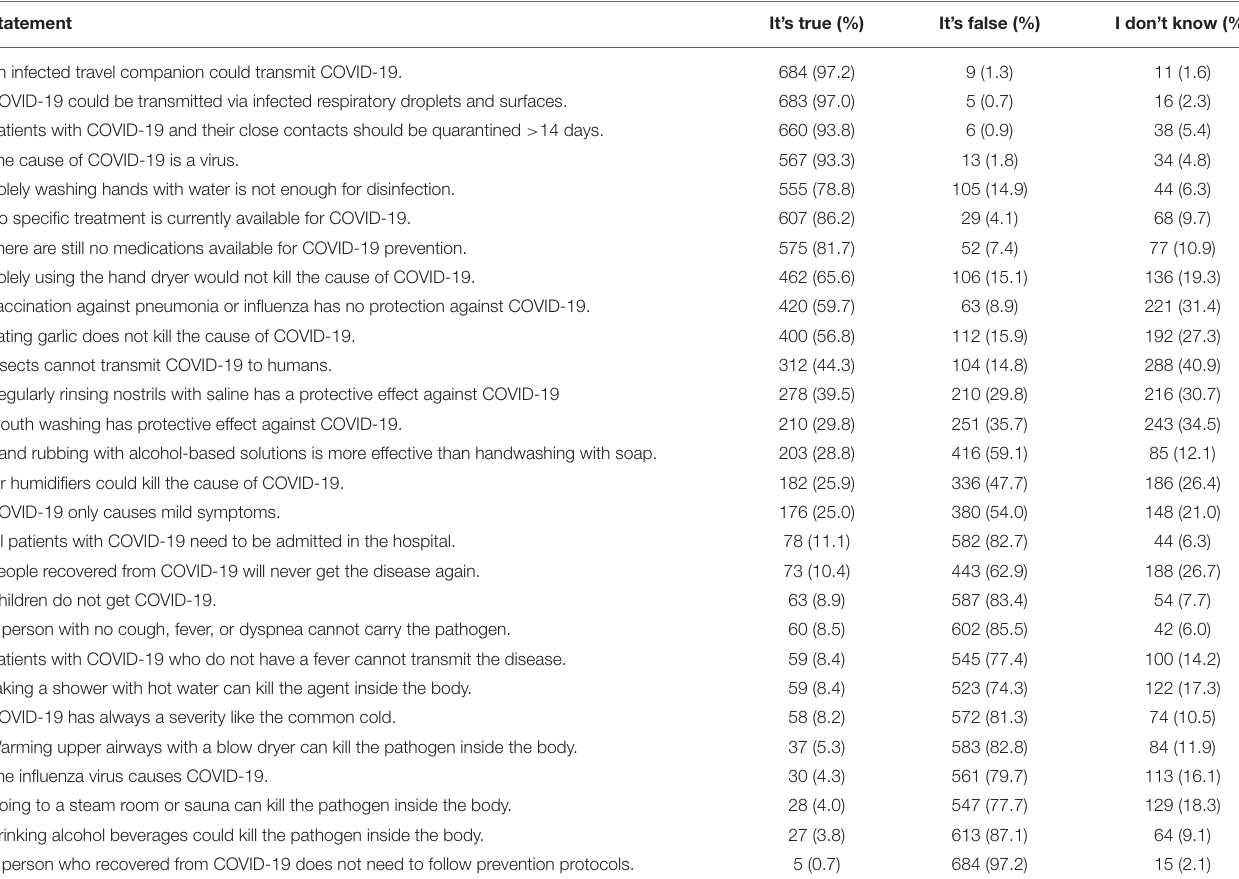
TABLE 3 | Students’ general knowledge about COVID-19.